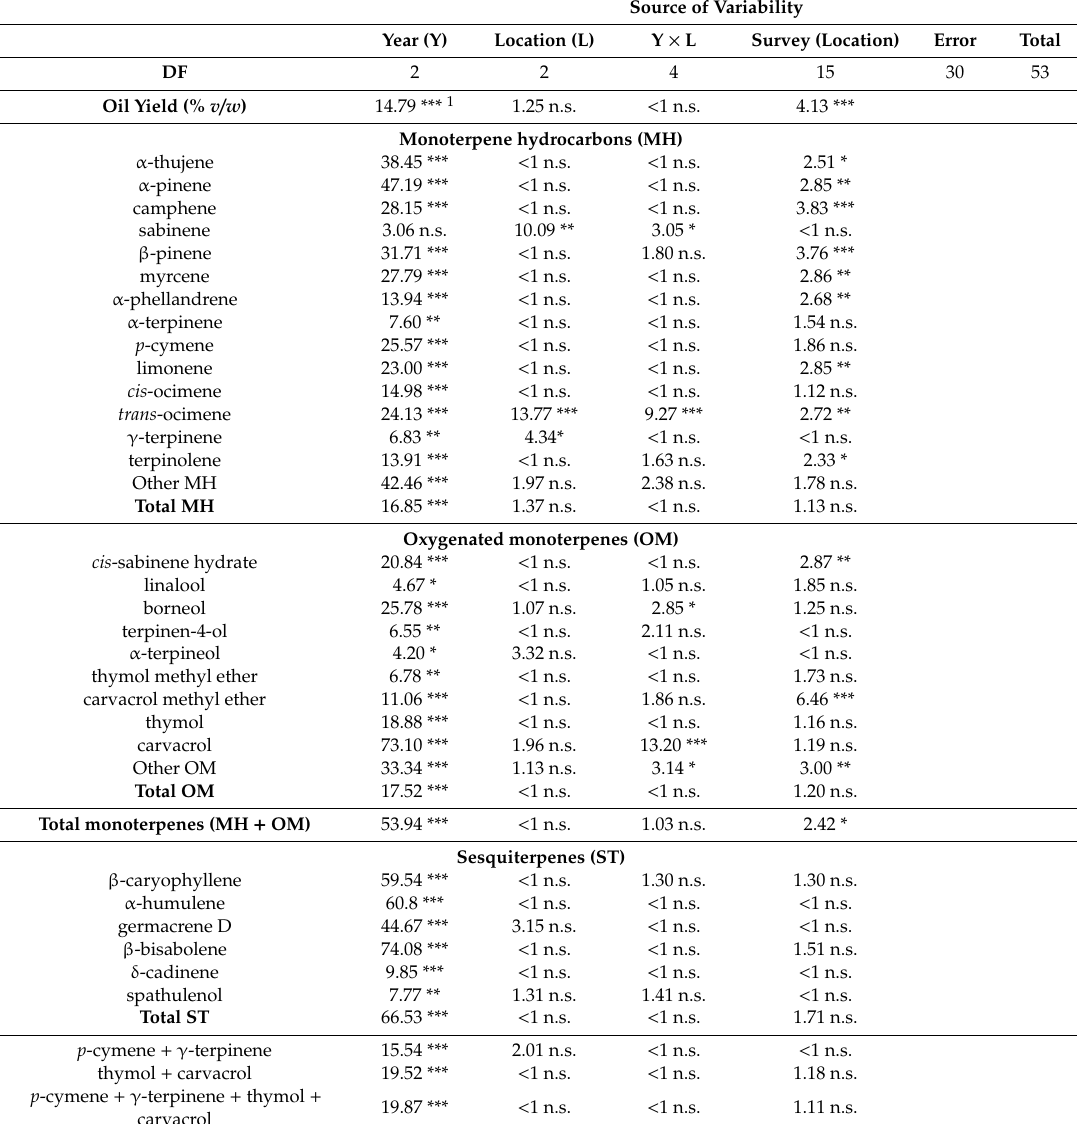
Table 5. O. heracleoticum . Results of ANOVA ( F values and significance level) for the yields and the major components of the EOs obtained throughout the